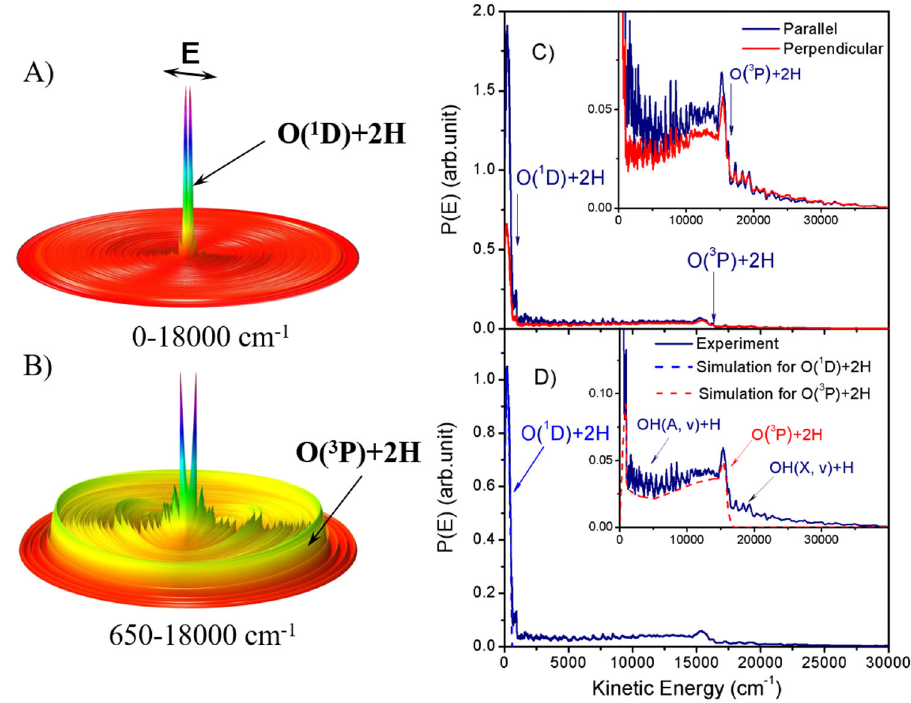
Fig. 1 The kinetic energy release spectra from H 2 O photodissociation. A The 3D product contour diagram from the photodissociation of H 2 O at 107.4 nm for the total kinetic energy release (TKER) between 0 and 18,000 cm − 1 ; B the 3D product contour diagram for the TKER between 650 and 18,000 cm − 1 . C The product TKER distributions at λ = 107.4 nm with the detection axis parallel and perpendicular to the polarization vector of the VUV-FEL radiation. The energetic limits of the two TBD channels ( E KEmax ~580 and ~16,448 cm − 1 ) are marked, and the inset displays the same spectra on an expanded vertical scale. D The product TKER distribution at λ = 107.4 nm with the detection axis at 54.7° (magic angle) to the polarization direction, along with the simulated TKER distributions for the O( 1 D) + 2H and O( 3 P) + 2H TBD channels. Source data are provided as a Source Data fi